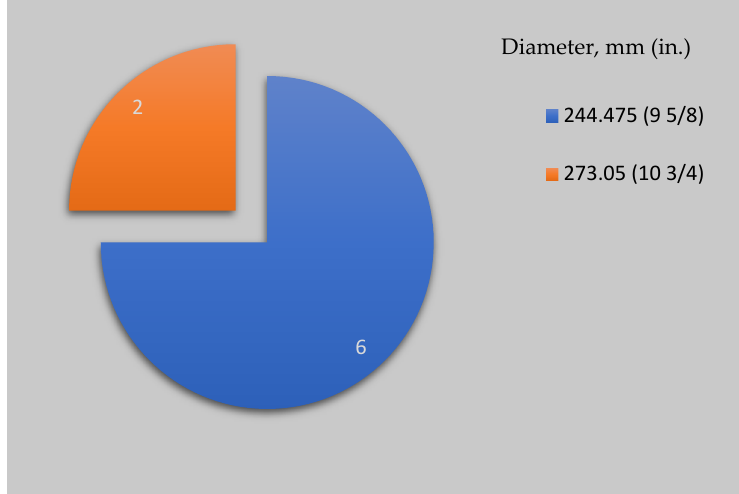
Figure 10. Diameter of intermediate casing I in the 24 analyzed wells.